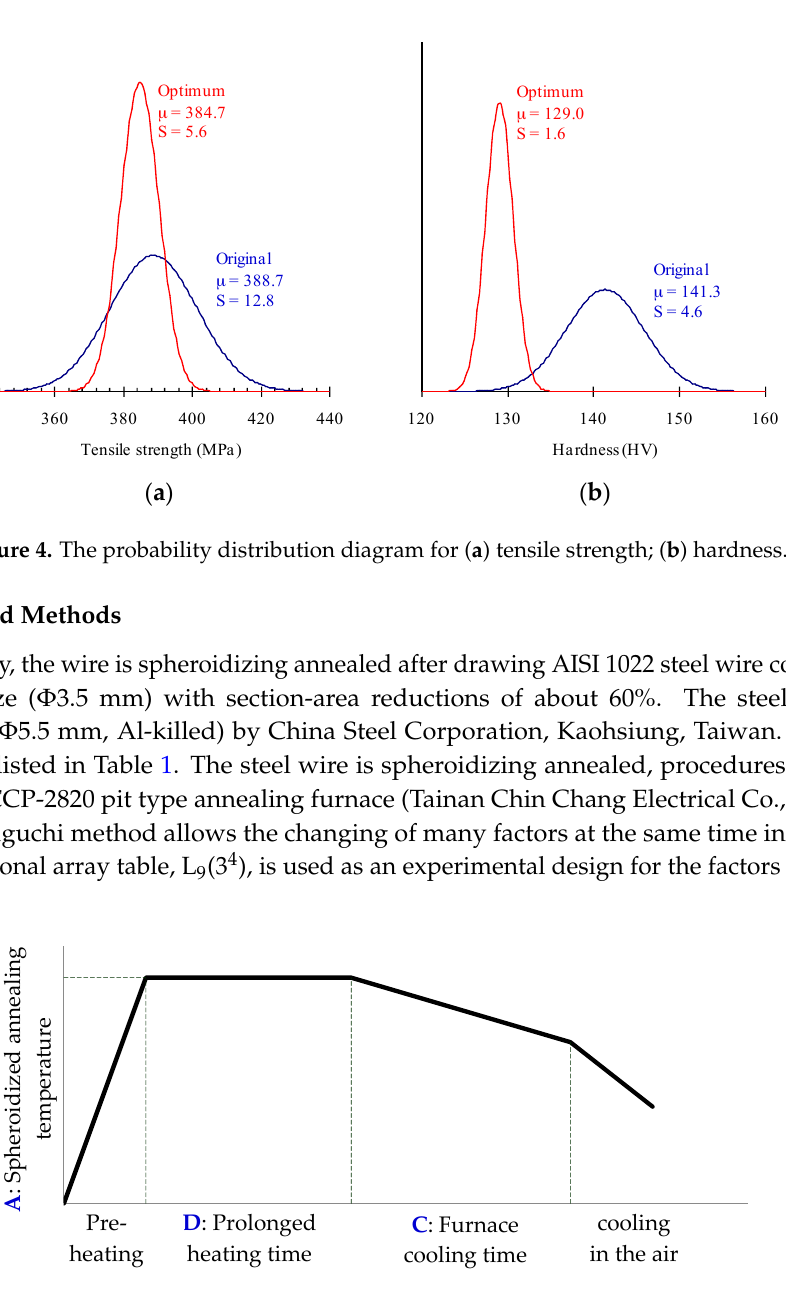
Figure 5. The spheroidized annealing procedure.